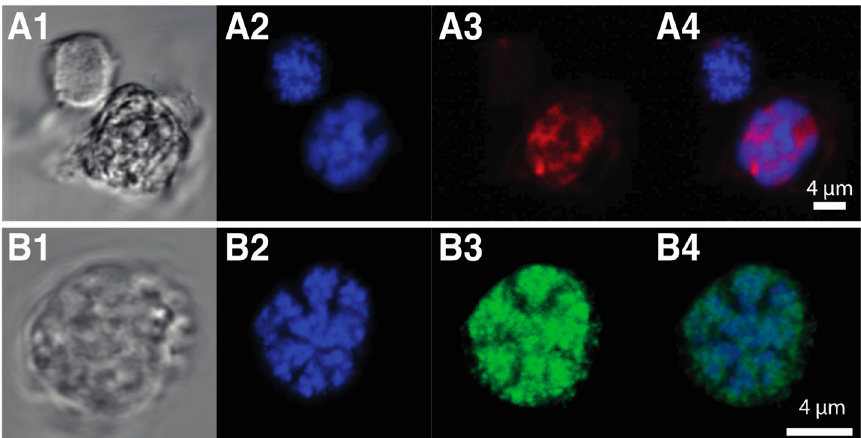
Figure 3. Visualization of two unique characters of dinoflagellate chromatin. ( A ) Assay for Transposase-Accessible Chromatin (ATAC)-see results ( A1 ) Brightfield image of two Hematodinium sp. cells. ( A2 ) DNA staining of the same cells ( A3 ) ATAC-see results show that in dinoflagellates at least two chromatin states exist with one nucleus highly stained while a second nucleus is not affected. This resembles accessible euchromatin and inaccessible heterochromatin states found in nuclei of other non-dinoflagellate eukaryotes. ( A4 ) Merged image of A2 and A3 . ( B ) DVNP immunolocalization. ( B1 ) Brightfield image of a Hematodinium sp. cell. ( B2 ) DNA staining of the same cell. ( B3 ) DVNP distribution in the nucleus revealed using a polyclonal anti-DVNP antibody. ( B4 ) Merged image of B2 and B3 .